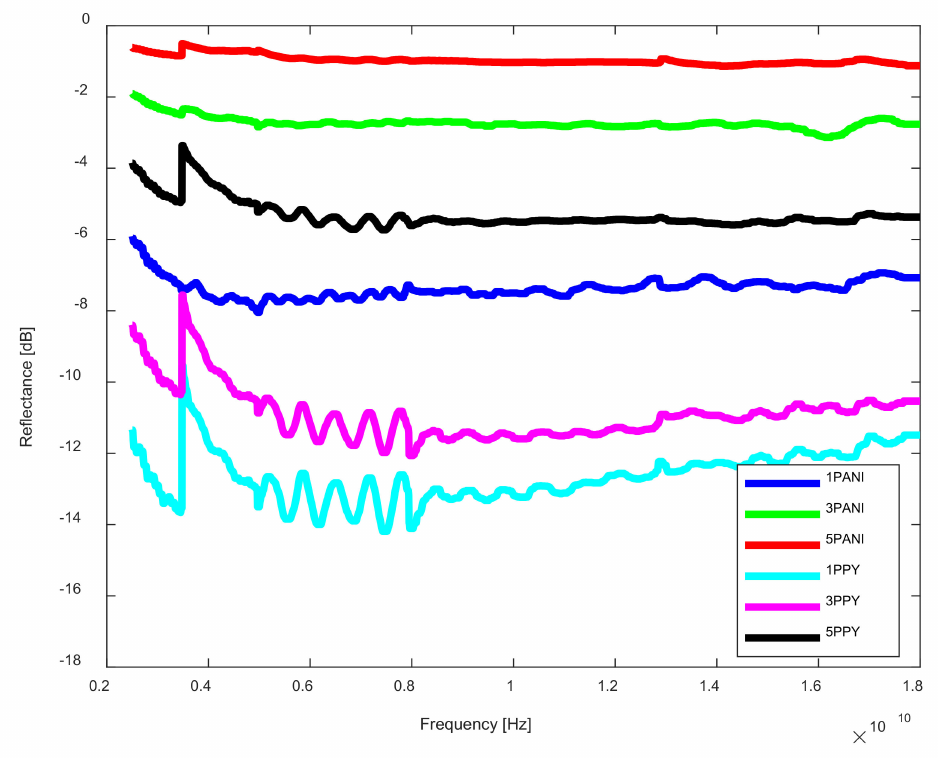
Figure 8. Results of measurements of reflectance in the tested frequency range from 2.5 to 18 GHz for textile samples inkjet printed with conductive polymers PANI and PPy. Table 3. Average values of shielding efficiency, transmission, reflection and absorption in dB and